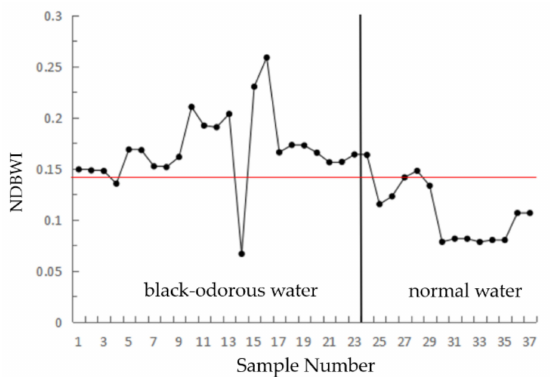
Figure 7. Normalized black-odorous water index.